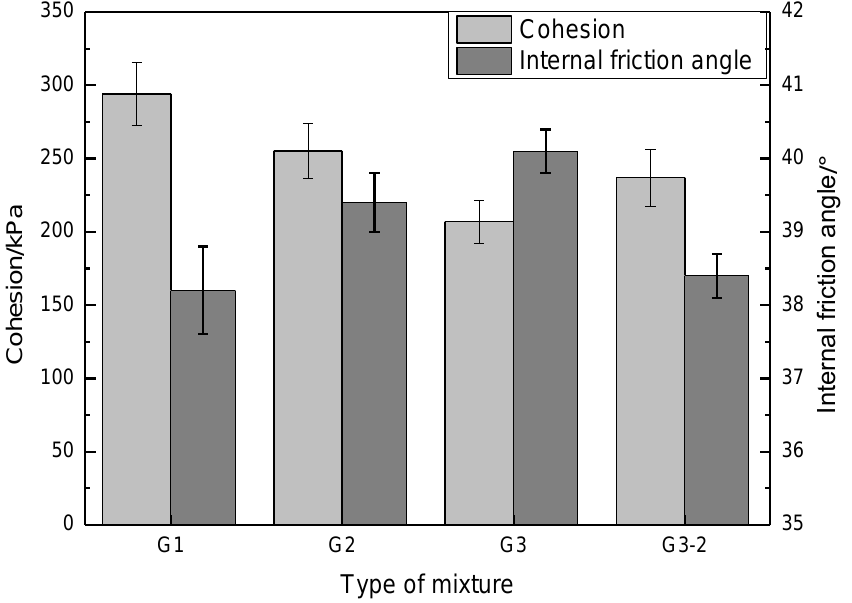
8 of 15 Figure 4. UCS and ITS results for the mixtures with different fine aggregate gradations. The calculated results of the triaxial shear parameters, fracture energy and maximum failure strain are shown in Figure 5 and Table 7. According to the triaxial test results in Figure 5, as the fine aggregate gradation coarsened, the cohesion of CRME also decreased